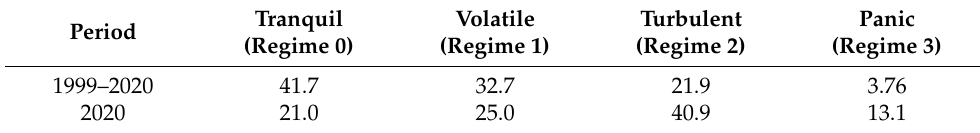
Figure 2. Time-series plots for the S&P 500 returns and different regimes based on smoothed probabilities. Table 10. Percentage of time spent by the S&P 500 index in each